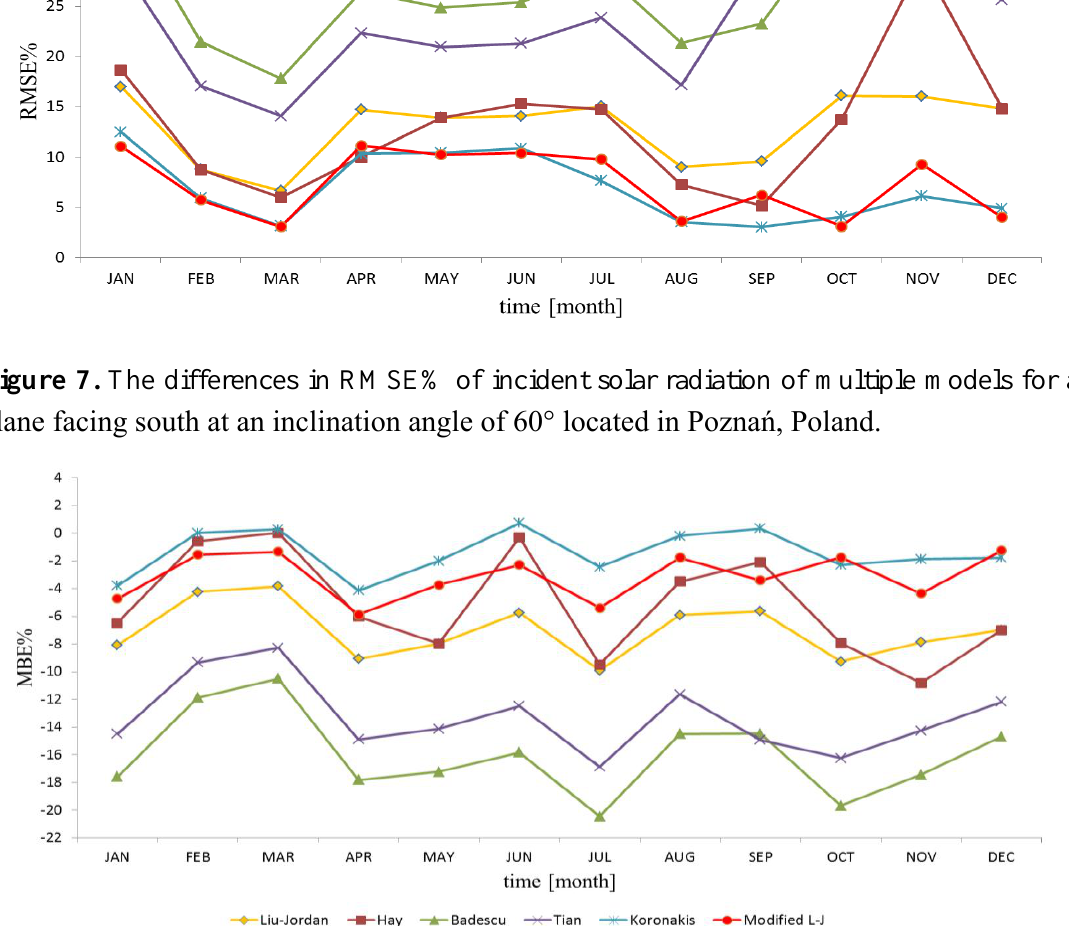
Figure 8. The differences in MBE% of incident solar radiation of multiple models for a plane facing south at an inclination angle of 60° located in Poznań, Poland.